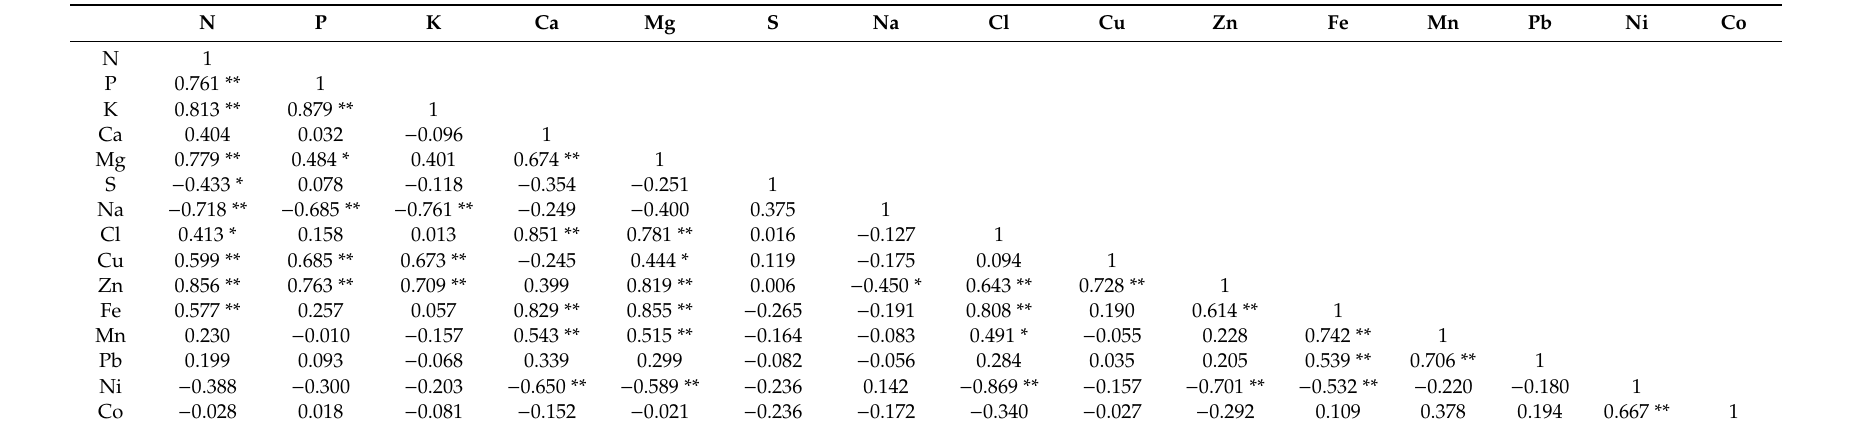
Table 9. Pearson’s correlation coe ffi cients between the contents of di ff erent nutrients in alfalfa